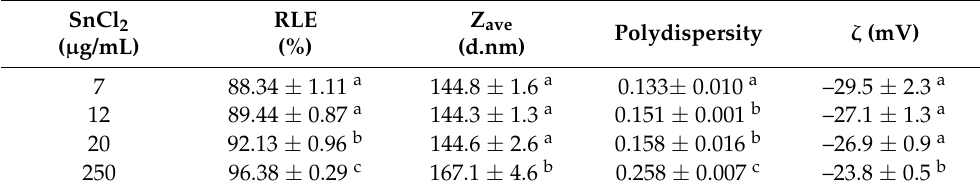
Table 1. Radiolabeling efficiency and hydrodynamic characteristics of the silk fibroin NPs as a function of SnCl 2 during radiolabeling. SnCl 2 RLE Z ave ( µ g/mL) (%) (d.nm)